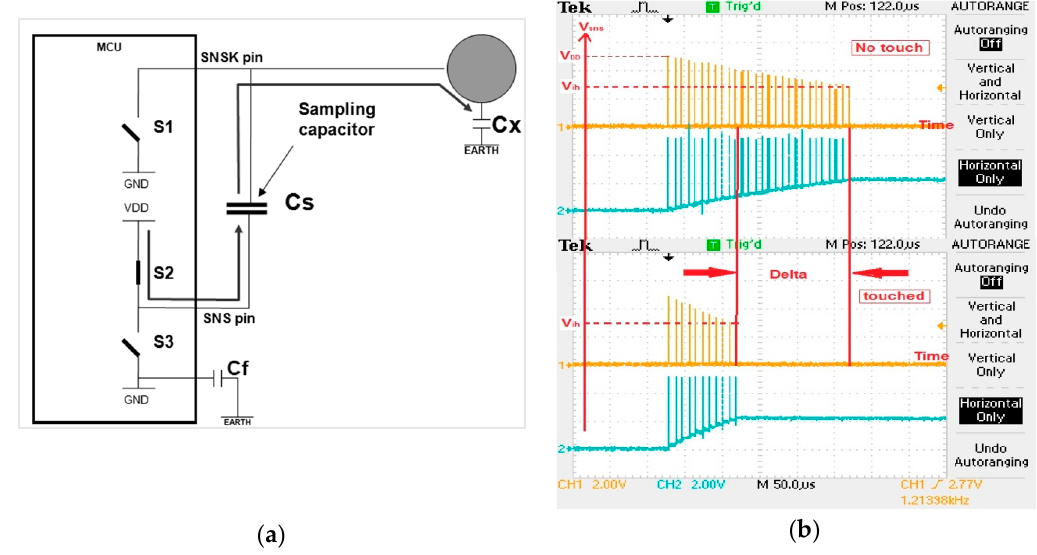
Figure 4. ( a )The equivalent circuit in charging phase; ( b ) Voltage waveforms across C s .